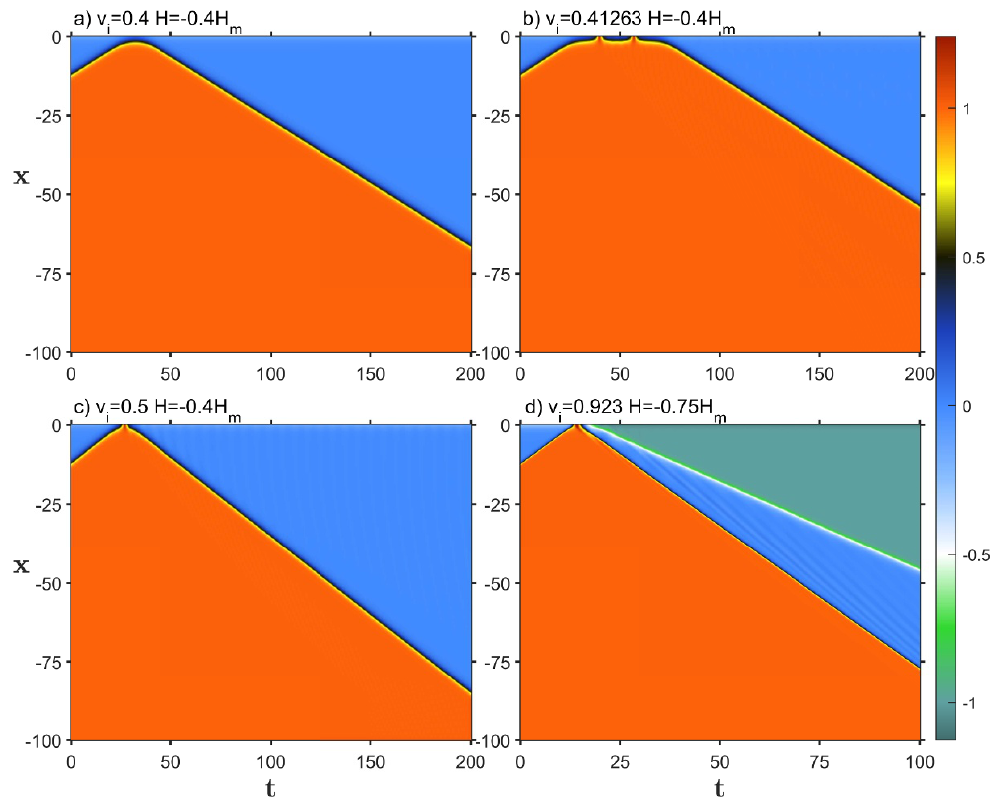
Figure 16 . Antikink scattering for H < 0 a) for v i < v c the antikink does not even reach the boundary due to the repulsive force, b) two-bounce scattering for v ∗ < v i < v c , c) one-bounce scattering for v i > v c then the antikink collides once and return, d) For v i > v c and large values of H the scalar field accesses the other topological sector. Compare with figure